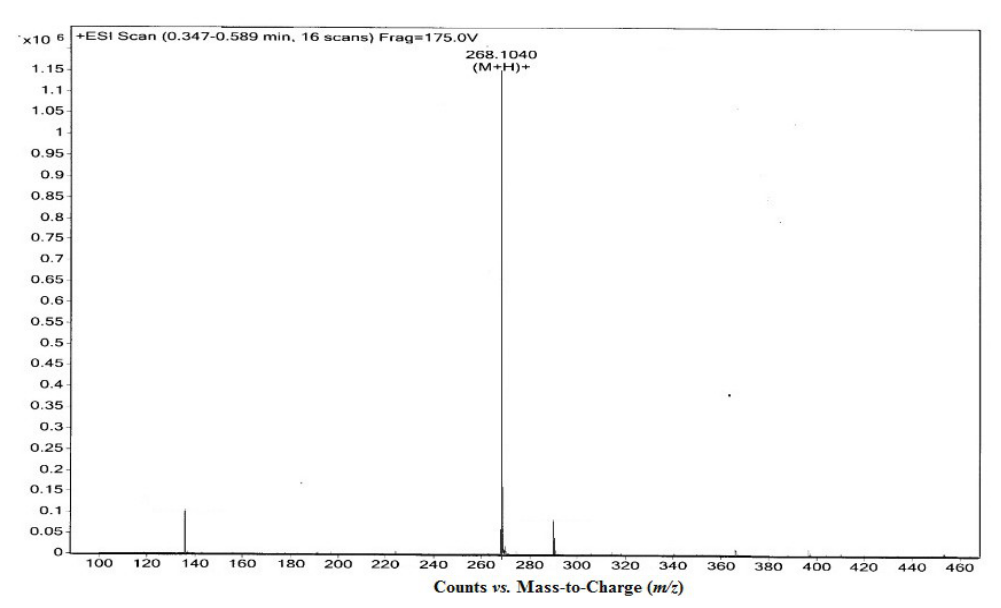
Figure 4. Chromatogram of fraction PB3 of P. adiposa and standard adenosine in the same mobile